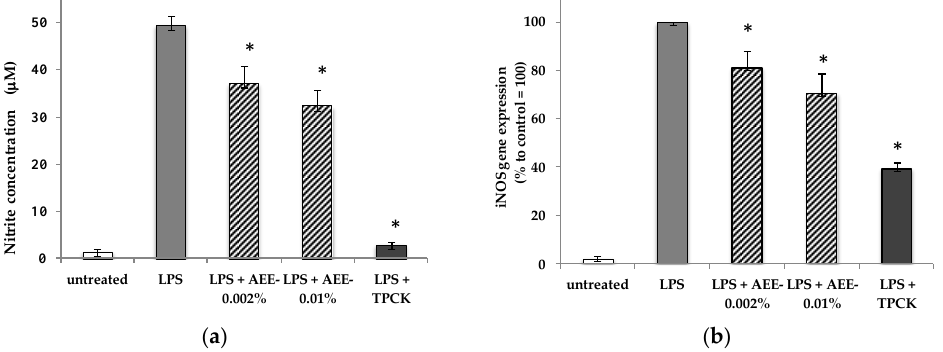
Figure 1. Protection against inflammation. The levels of NO production ( a ) and iNOS gene expression ( b ) were measured in RAW 264.7 macrophages treated with AEE before addition of bacterial liposaccharide LPS. TPCK was used as positive control. All determinations were conducted in triplicate and results are expressed as mean ± SD. * p < 0.05.